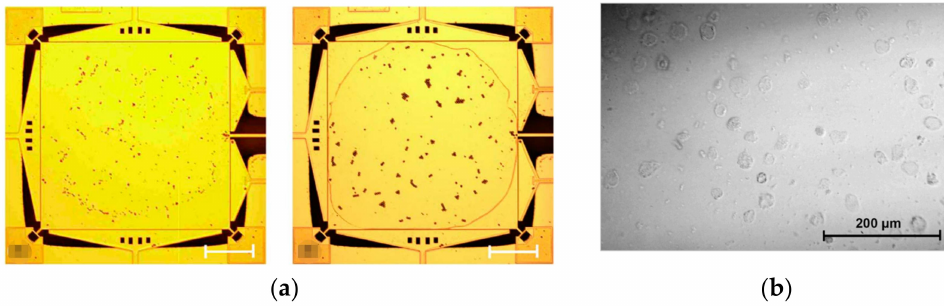
Figure 26. Optical micrograph of attached analytes. ( a ) SCPMs with diameters of 5.61 µ m and 15.68 µ m; ( b ) High Five insect cells. Reprinted with permission from Ref. [40].